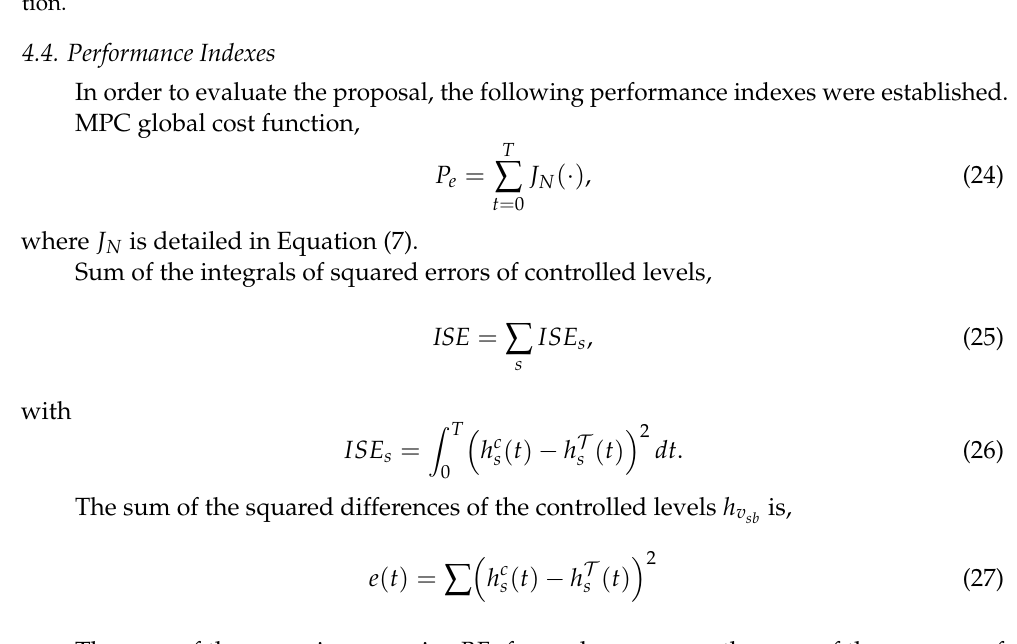
Figure 5. Gradient estimation variance approach by exploration policy based on categorical distribu-